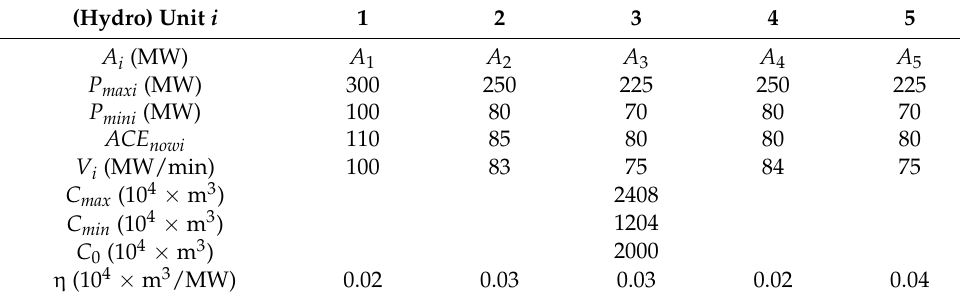
Table 4. Relevant characteristic parameters of TPU.